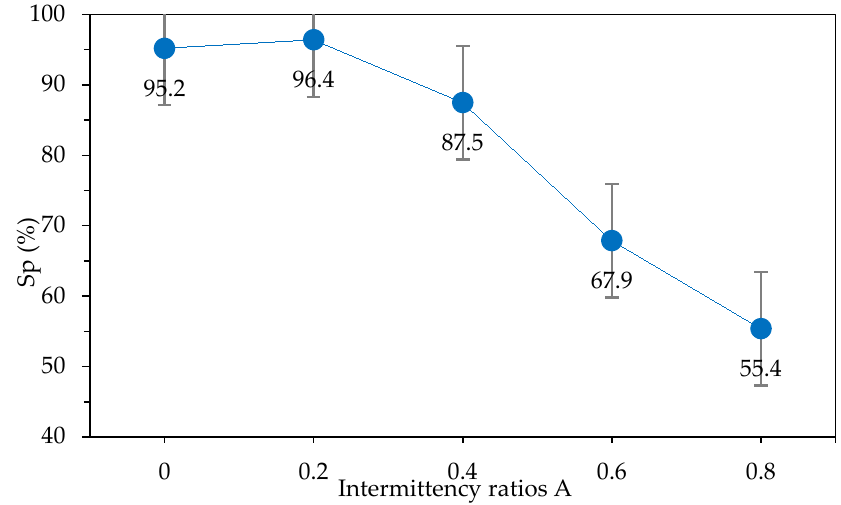
Figure 11. Effect of intermittent drying on saponin content.